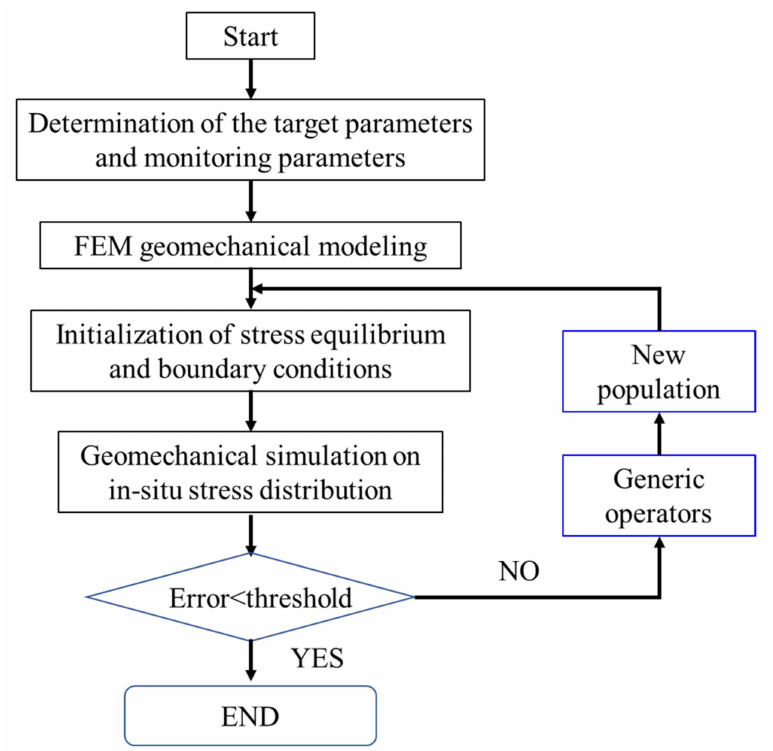
Figure 5. Reversion of in-situ geostress coupling FEM simulation with GA.